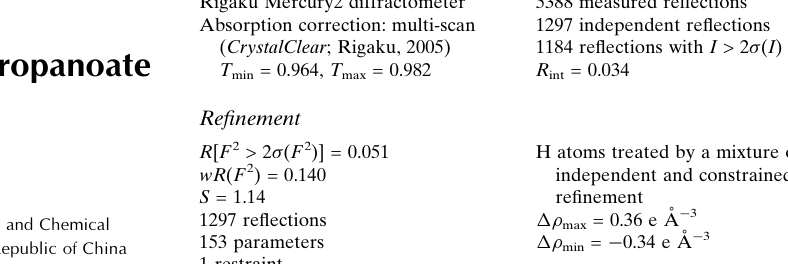
Rigaku Mercury2 diffractometer Absorption correction: multi-scan